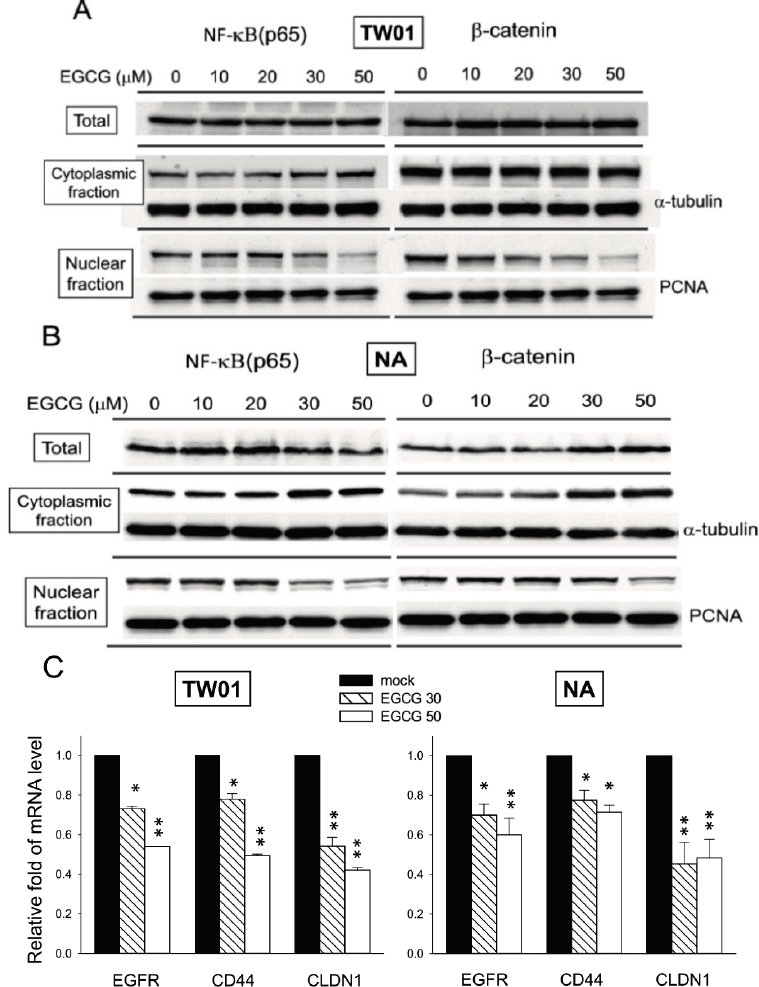
Figure 8. EGCG suppresses the nuclear translocation of NF- κ B and β -catenin and the expression of downstream genes. Western blot analysis of total, cytoplasmic, and nuclear fractions of NPC cells after 24 h of EGCG treatment is presented. The levels of NF- κ B and β -catenin are shown. α -Tubulin and PCNA are detected as a loading control for the cytoplasmic and nuclear fractions, respectively. ( A ) TW01 cells; ( B ) NA cells; and ( C ) qRT-PCR of EGFR, CD44 and CLDN1 in NPC cells. The RNA level of these genes in mock-treated cells was adjusted as the base line (1.0-fold) and the relative gene expression level in EGCG-treated cells was determined accordingly. Data indicate the mean expression level ± SD. *: p < 0.05; **: p < 0.01, compared to the mock-treated